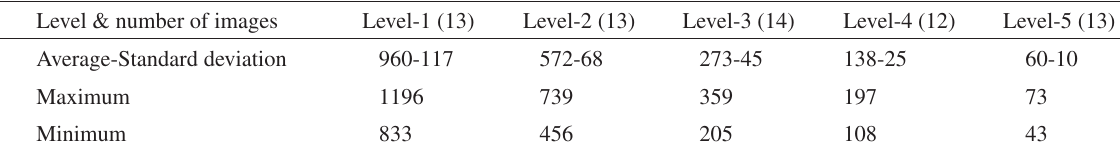
Statistics of number of detected cells for different levels of positive cell intensity Level & number of